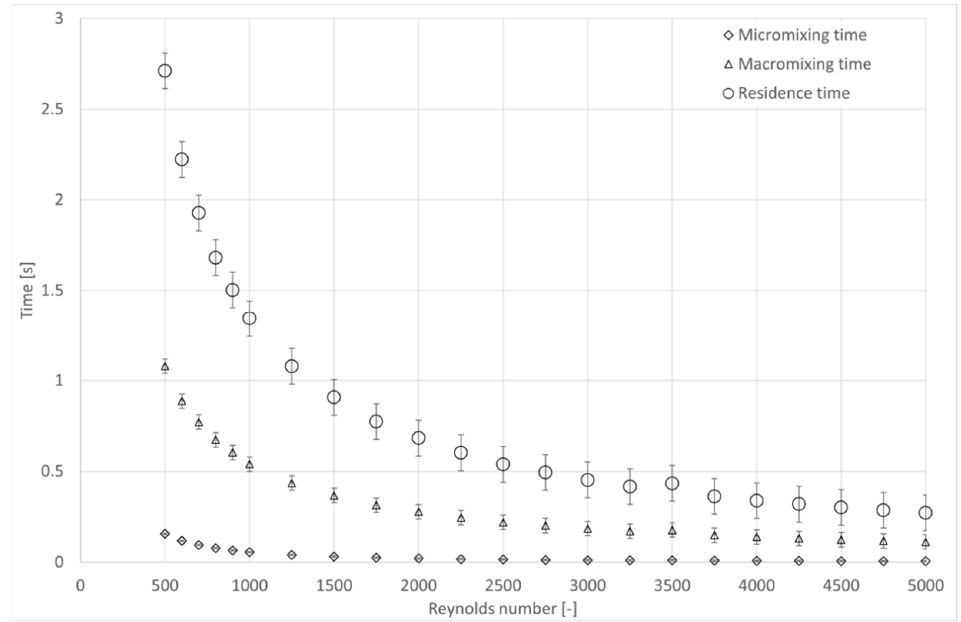
Figure 2. Distribution of micromixing, macromixing and residence time in a function of Reynolds Number (Re).